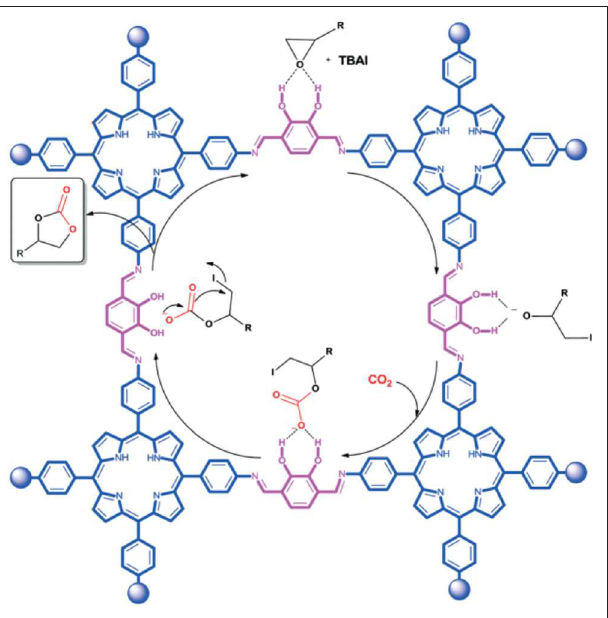
FIGURE 21 | Reaction mechanism proposed by Saptal et al. for the synthesis of cyclic carbonates from carbon dioxide and epoxide catalyzed by 2,3-DhaTph COF as a catalyst system. Reprinted with permission © The Royal Chemistry Society.